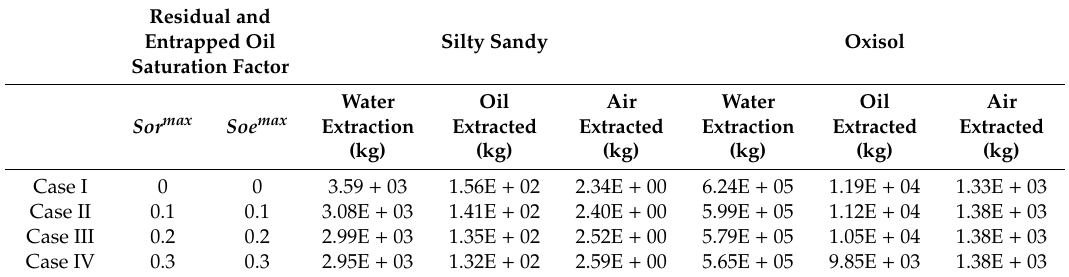
Table 3. Fluids extraction after MPE application for different cases.